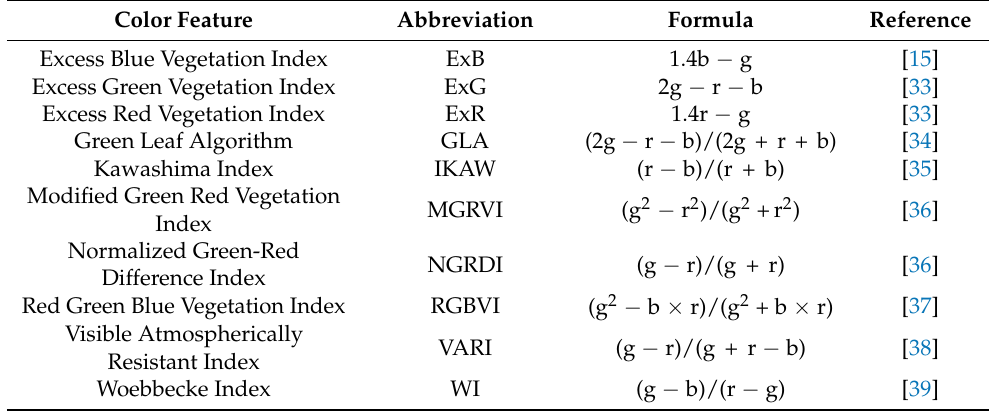
Table 3. Color features used for monitoring powdery mildew of rubber trees in this